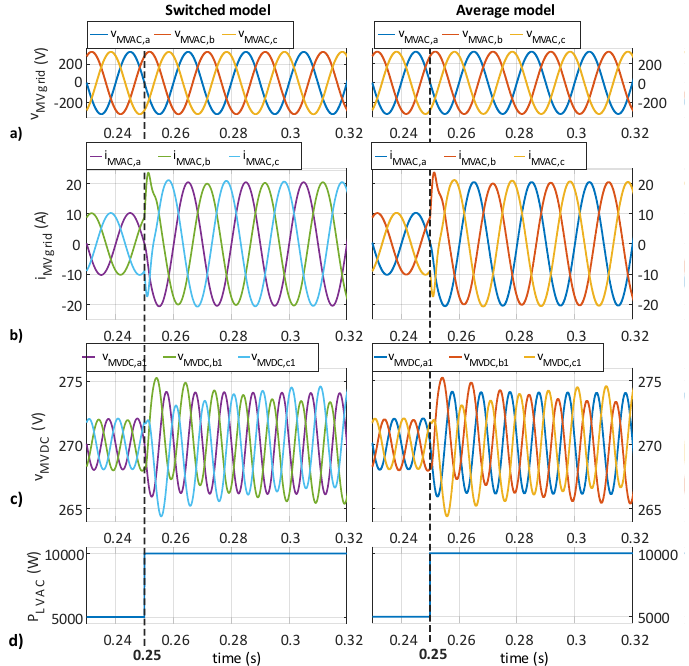
Figure 10. The voltages and currents of the CHB, ( a ) grid voltages on the MV side of ST, ( b ) grid currents, ( c ) DC-link voltages for one module in each phase, ( d ) referenced power value. Energies 2020 , 13 , x